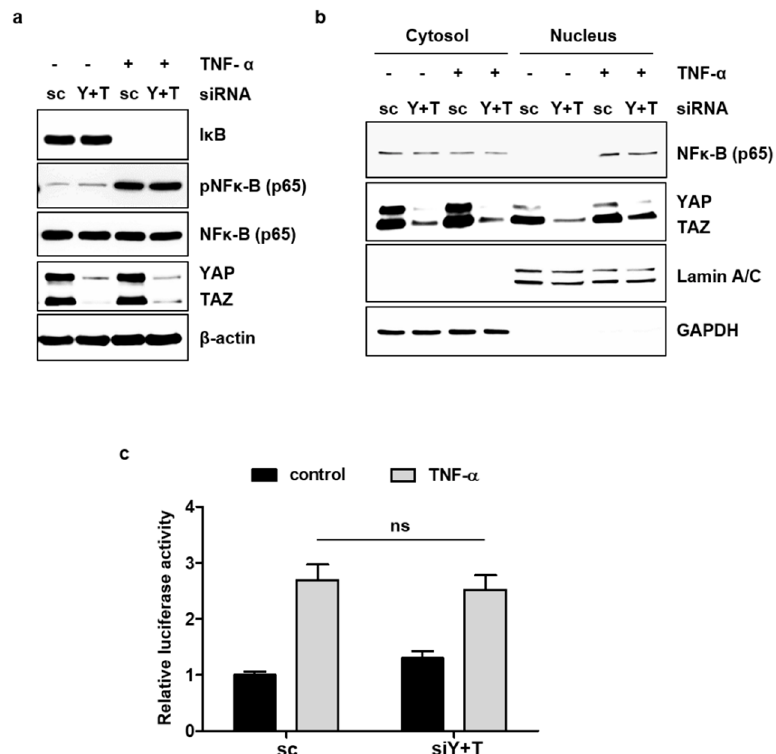
Figure 5. YAP does not affect the TNF- α -induced activation of NF- κ B signaling. ( a ) HUVECs were transfected with scrambled control (sc) or YAP/TAZ (Y+T) siRNA for 48 h. The cells were treated with TNF- α for 30 min. Whole cell lysates were analyzed by immunoblotting with anti-I κ B, anti-pNF- κ B (p65), anti-NF- κ B (p65), and anti-YAP/TAZ antibodies. ( b ) HUVECs were transfected and treated with TNF- α as described in ( a ). Nuclear and cytoplasmic extracts were prepared, and each extract was analyzed by immunoblotting with the indicated antibodies. ( c ) HUVECs were transfected with the pNF- κ B-Luciferase reporter plasmid and the pRL-Tk internal control vector 24 h after siRNA transfection. The cells were stimulated with TNF- α for 6 h, and luciferase activity was measured. All experiments were repeated three times ( n = 3), and data are presented as the mean ± S.E.